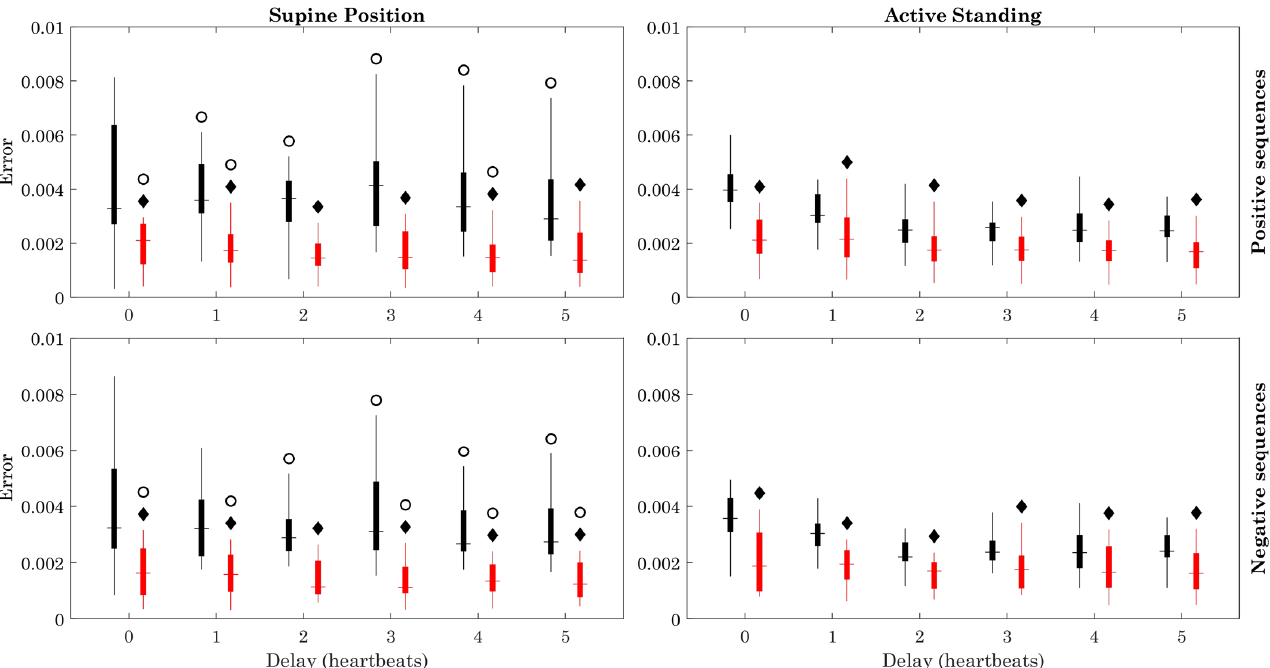
Figure 6. Estimation error. Figure symbology: Healthy subjects (black), ESRD patients (gray). Black diamond: ESRD vs. Healthy group (within same position), p < 0.05. Open circle: Supine Position vs. Active Standing (within same group), p < 0.05.